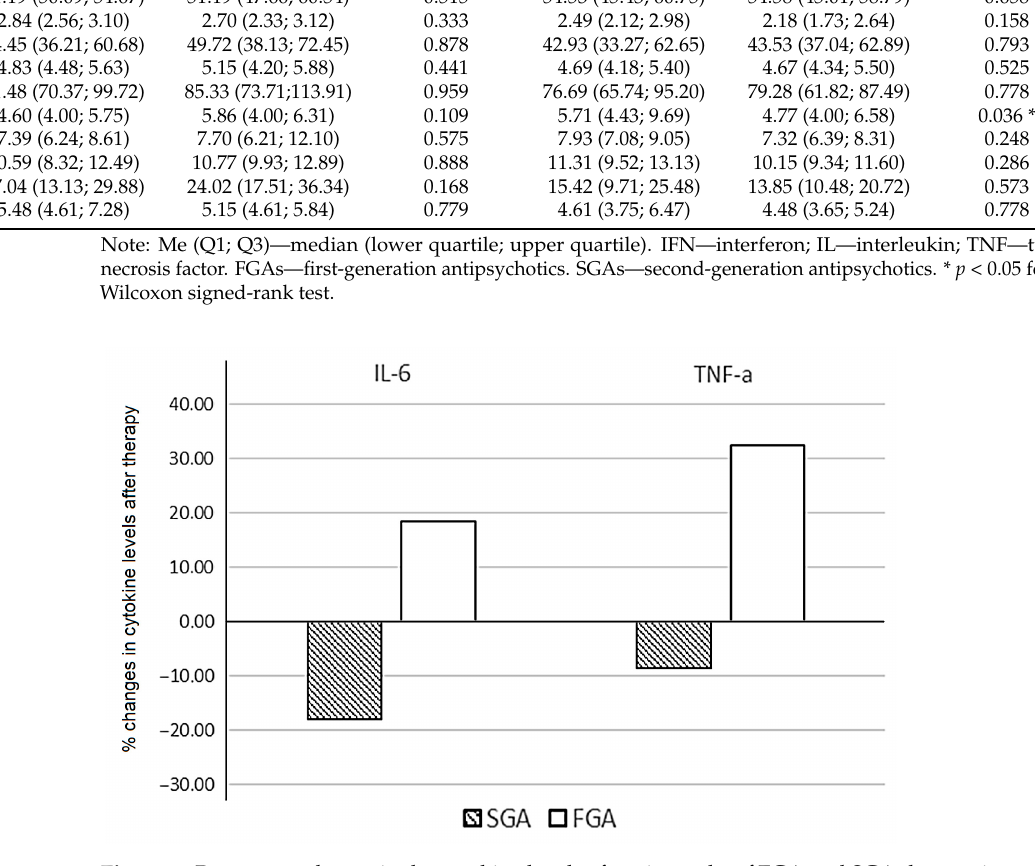
Figure 3. Percentage change in the cytokine levels after six weeks of FGA and SGA therapy in patients with schizophrenia.